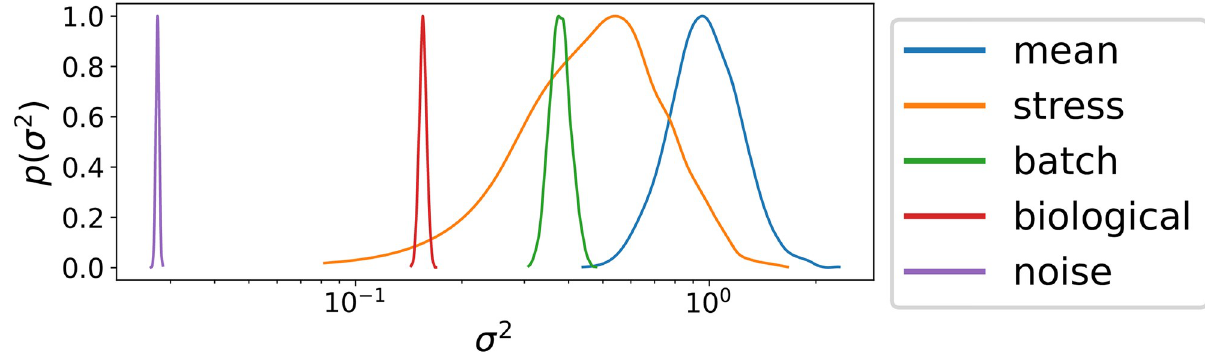
Fig 6. Posterior variance components in the phenom hierarchical phenotype model. Posterior intervals are shown for the kernel variance hyperparameter for different groups of effects from phenom estimated on H. salinarum growth under low OS. Groups correspond to m ( t ) (mean), δ ( t ) (stress), batch effects (batch), replicate noise (biological), and measurement error (noise).